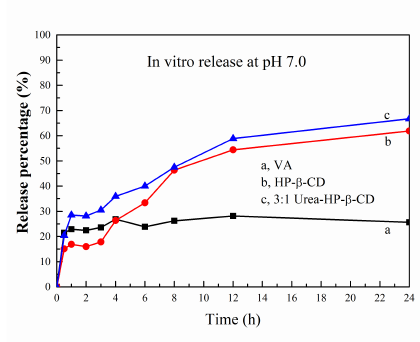
Fig. 7. VA Release profiles (a) VA (b) HP- β - CD (c) 3:1 Urea-HP- β -CD at pH 4.5.